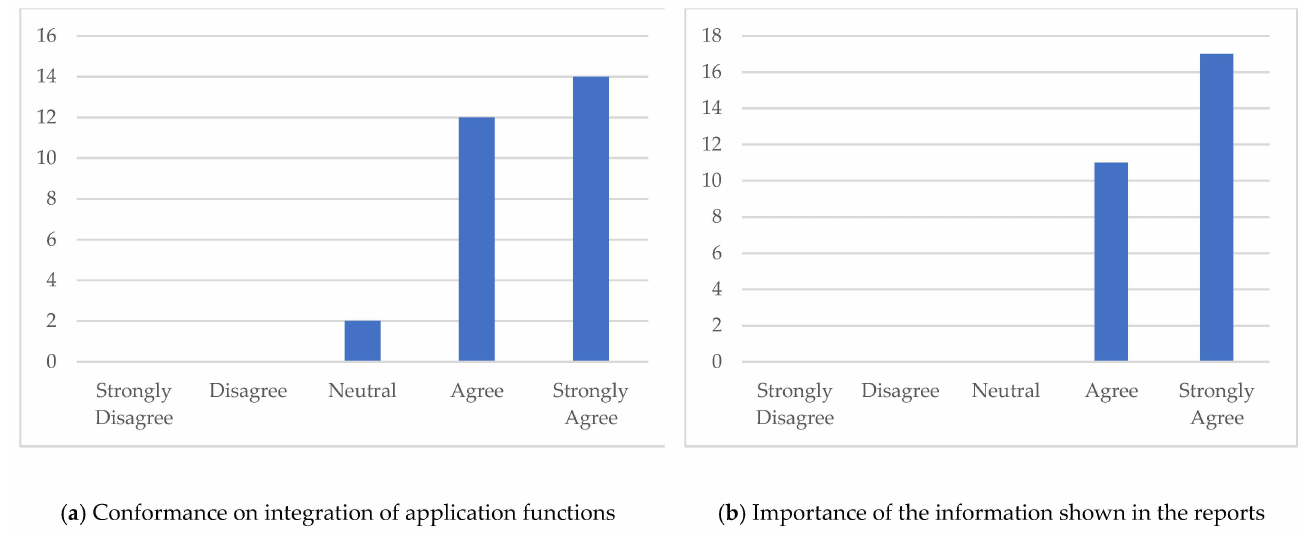
Figure 10. Levels of integration and importance of the functions implemented in both (mobile and web)